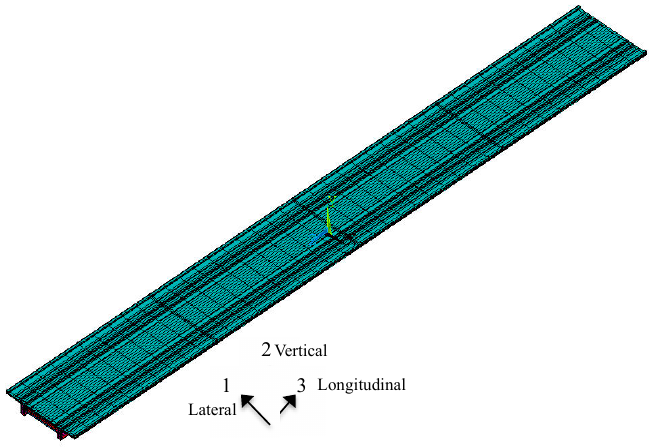
Figure 3 Finite element model of a twin-I girder bridge with precast concrete deck. Figure 3. Finite element model of a twin-I girder bridge with precast concrete